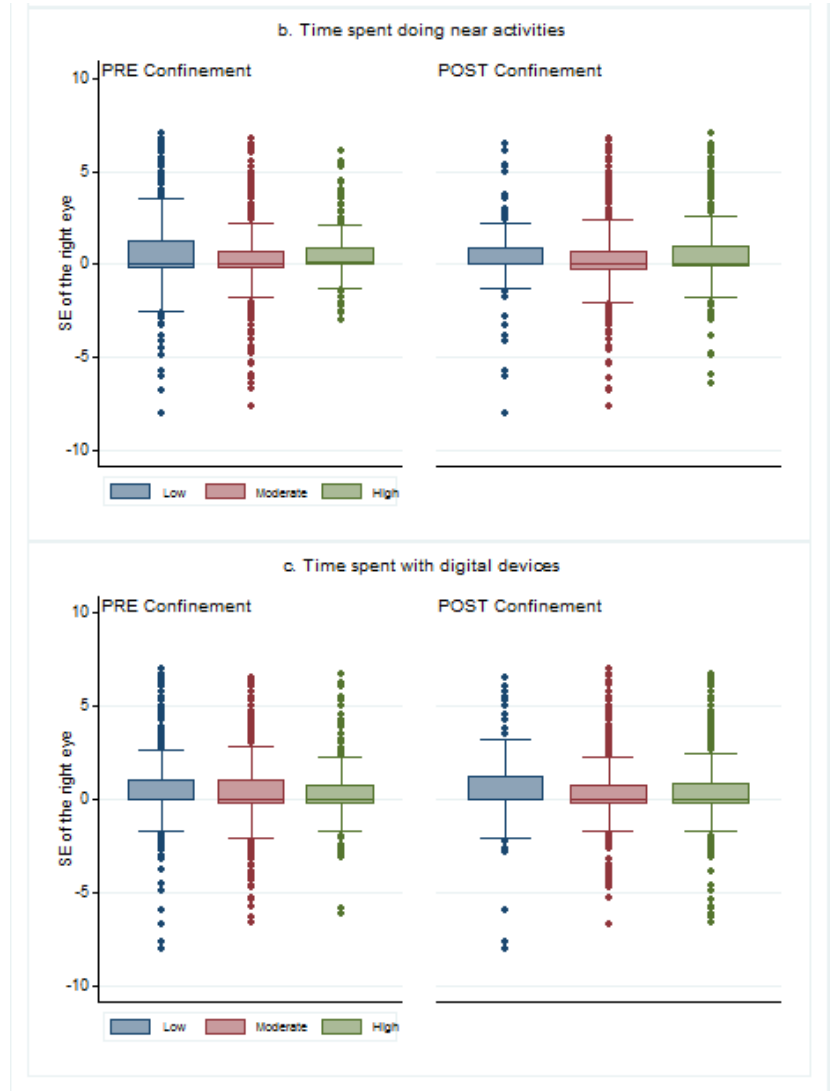
Figure 6. Spherical equivalent of children depending on their lifestyles before and after confinement: ( a ) depending on the time spent outdoors classified as low (under 1.6 h a day), moderate (between 1.6 and 2.7 h a day), and high (more than 2.7 h a day) times; ( b ) depending on the time spent doing near activities, divided into low (less than two hours a day), moderate (between two and three hours a day), and high (more than three hours a day) times; ( c ) depending on the time with digital devices classified as low (less than 25% of the near-work time), moderate (between 25% and 50% of the near-work time), and high (more than 50% of the near-work time) times. The box was determined by Q1 (1st quartile) and Q3 (3rd quartile) and the whiskers were determined by Q3 + 1.5 IQR (upper whisker) and Q1—1.5 IQR (lower